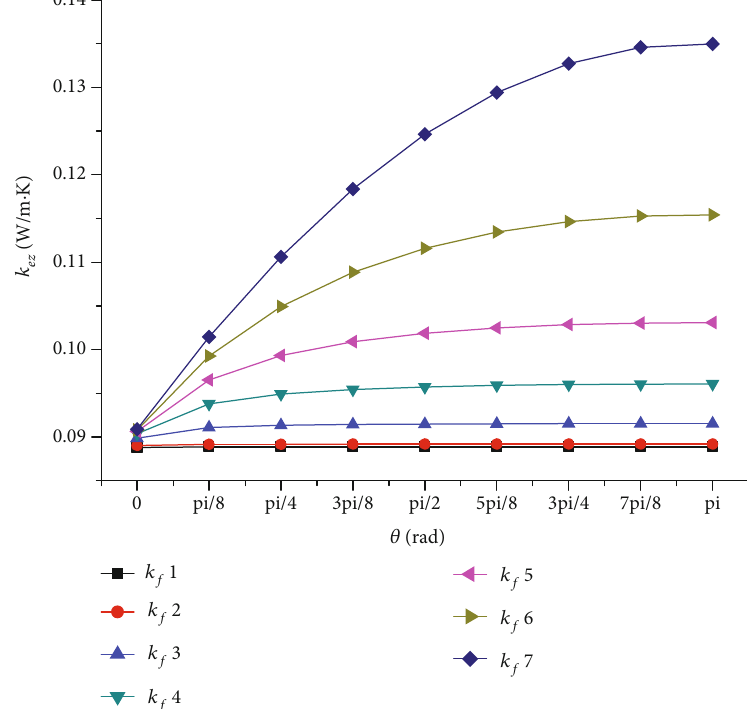
Figure 27: E ff ect of fi ber thermal conductivity and fi ber intersection angle on thermal conductivity.